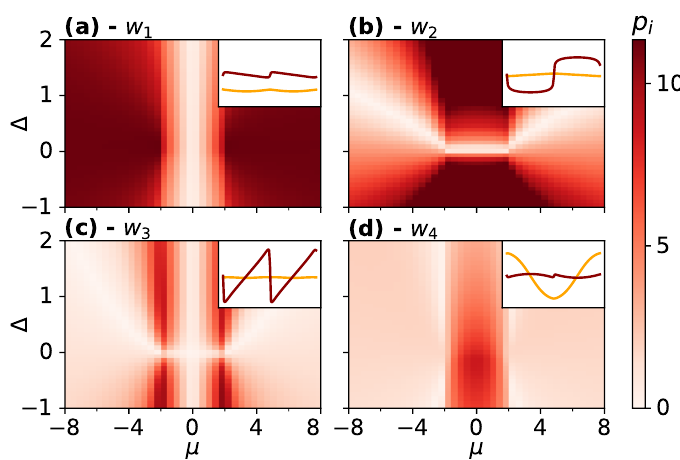
Figure 2: PCA of the non-interacting Hamiltonian. The quantified leading compo- nents (QLC) p measure the projections of the data onto the space of each of the first i four principal components, corresponding to the eigenvalues with largest explained = 0.451 reveals the points of the phase dia- variance ε . (a) The first QLC with ε i 1 = 0.421, highlights gram with trivial winding number. (b) The second QLC, with ε 2 the points of the phase diagram with non-trivial winding number, (c) The third QLC, = 0.052 shows the phase transition lines, (d) The fourth QLC with ε = 0.042 with ε 3 4 has a high projection on the phase with ν = − 1. The insets show the first (red cir- cles) and the second (orange triangles) 100 elements of the corresponding principal components w ( i = 1,2,3,4). i